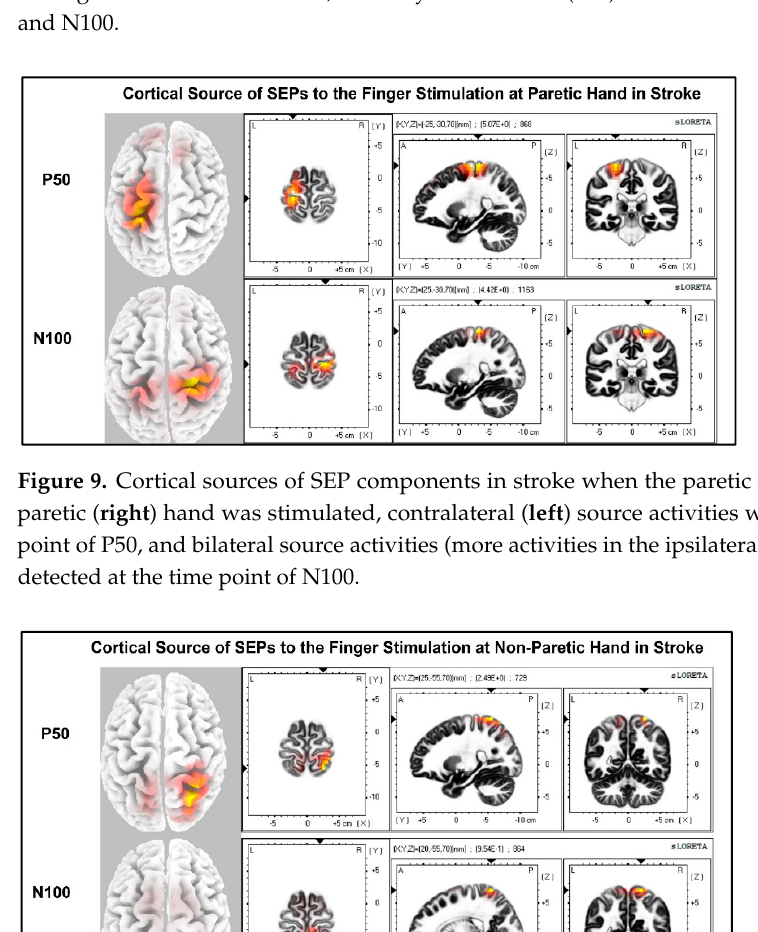
Figure 8. Cortical sources of Somatosensory Evoked Potential (SEP) components in Healthy Control. The right hand was stimulated, and only contralateral (left) cortical sources were detected for P50 and N100.